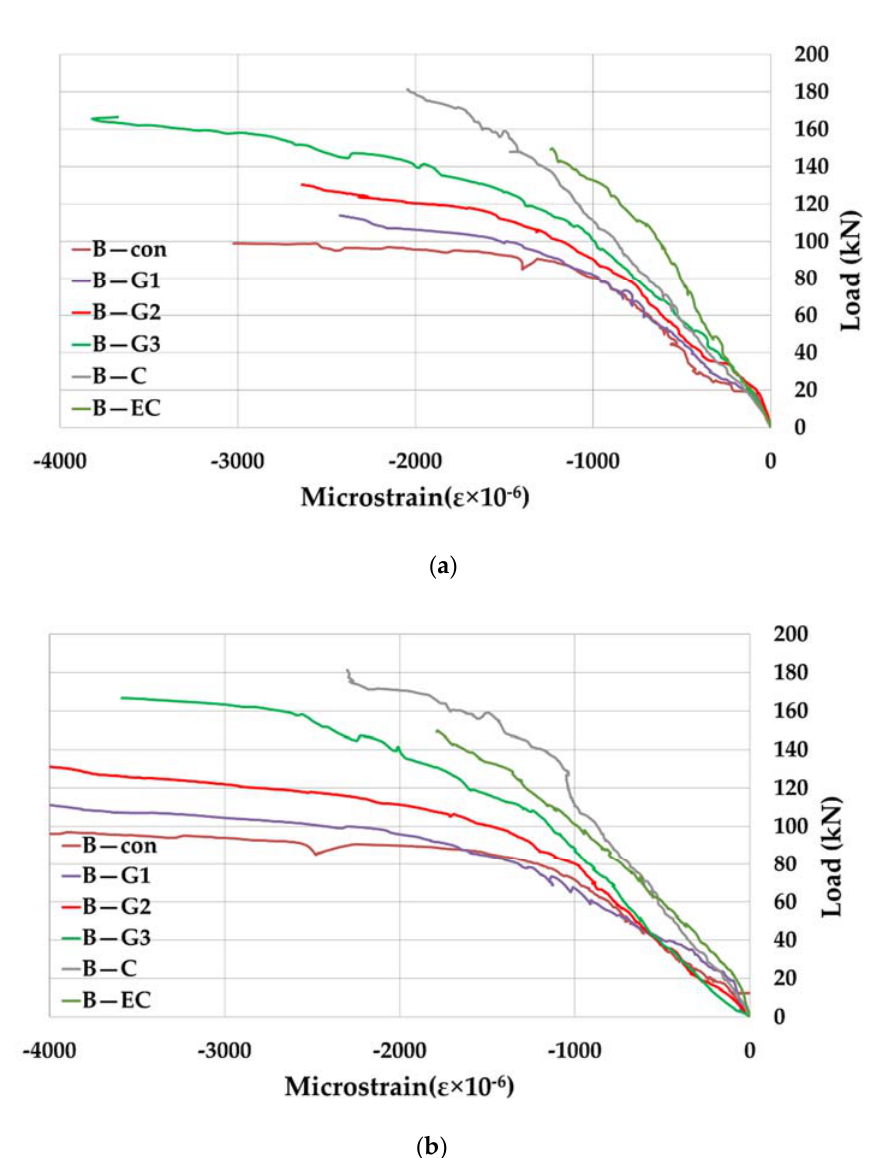
Figure 15. Load vs. microstrain curves for concrete for the section: ( a ) At the middle of span—Section I; ( b ) Above the middle support—Section III.